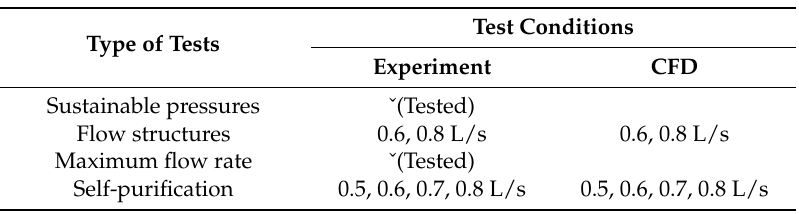
Table 1. Experimental and numerical test